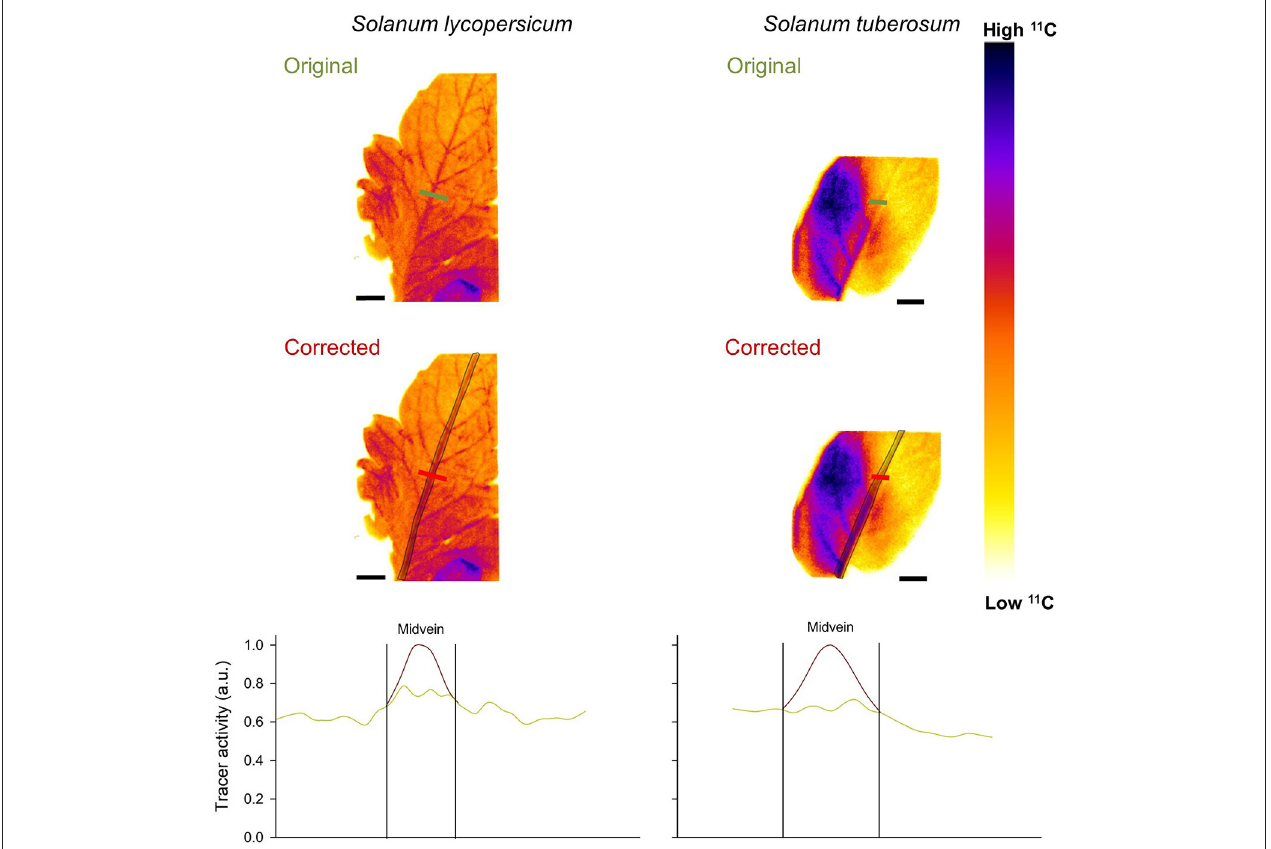
FIGURE 5 | Leaf 11 C-autoradiographs of Solanum lycopersicum and S. tuberosum . Correction is illustrated for the midvein, with the region enclosed by a black line corrected using the approach of Jødal et al. (2012). The profile plots show how the measured tracer intensity varies in and around the midvein, when corrected (red line) and uncorrected (green line). Tracer activity is expressed in arbitrary units (a.u.) with 1 the maximum intensity measured in the profile. Scale bars are